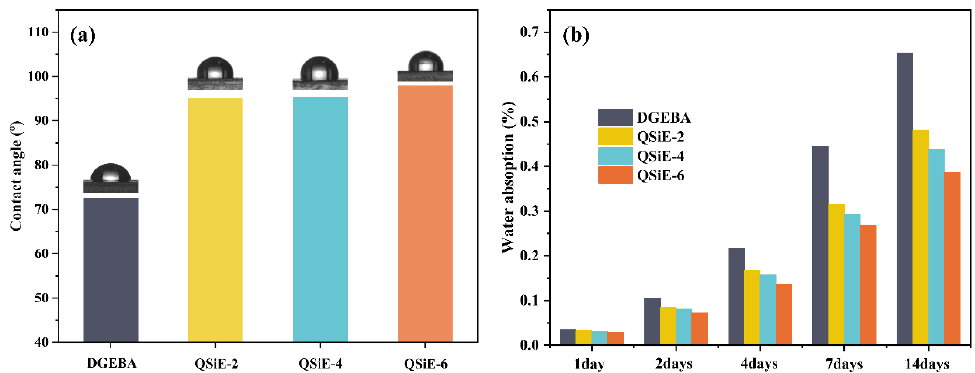
Figure 5. ( a ) Contact angle, ( b ) water absorption rate of cured